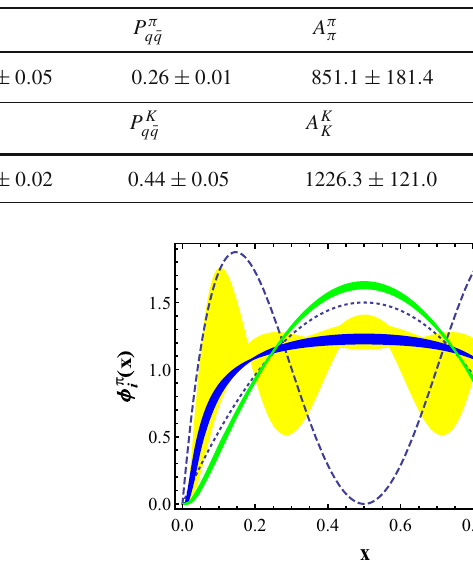
Table 1 The parameters of twist-2,3 distribution amplitudes for the pion and kaon mesons in Eqs. (27)–(29) with the scale value μ F = 1 GeV. The dimensions of the harmonic parameters β π, K and normal-